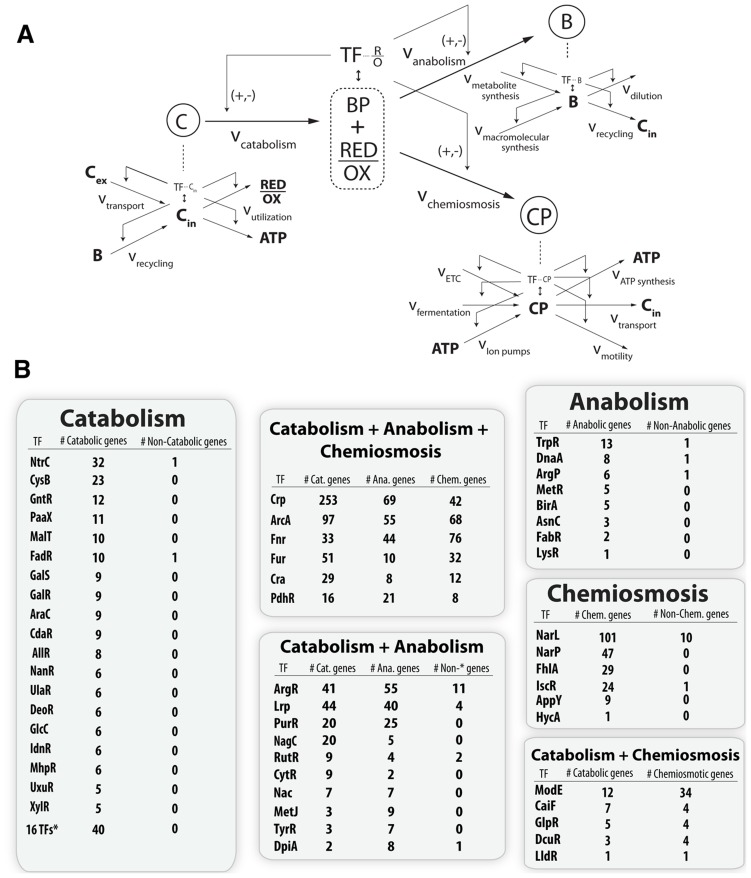
Topological organization of the joint metabolic-regulatory network.(A) Qualitative model where levels of the hierarchy represent a coarse graining of the total metabolic network around pools of key metabolites. Each metabolite has mass balanced production and consumption fluxes and often a corresponding TF sensor that can regulate the input and output fluxes. (B) Quantitative assessment of this regulatory scheme done by curation and classification of the regulatory targets for every TF known to sense a metabolite in the iJO1366 model (Table S13). The classification of a gene product into the catabolic, anabolic, or chemiosmotic metabolic pathways was done identically to the classification of figure 3. The main point is that the hierarchy of the regulatory network does in fact mirror the hierarchical dimensionality of the metabolic network. Regulators which sense a catabolite only regulate catabolic genes, regulators which sense an anabolite only regulate anabolic genes, and regulators which sense a chemiosmotic component only regulate chemiosmotic genes. However, metabolites that exist as both a catabolite and anabolite, or as both a catabolite and chemiosmotic component, tend to have regulators which regulate genes in each of the given categories. Similarly, TFs which sense molecules that are biomass precursors and energy precursors will necessarily globally regulate metabolic genes in all three categories. All curation results are available in a functional form at http://nbviewer.ipython.org/gist/steve-federowicz/f3a1ad0f86158d3f672e.